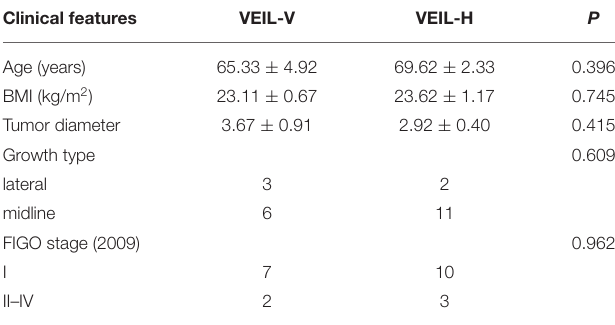
TABLE 1 | General data of